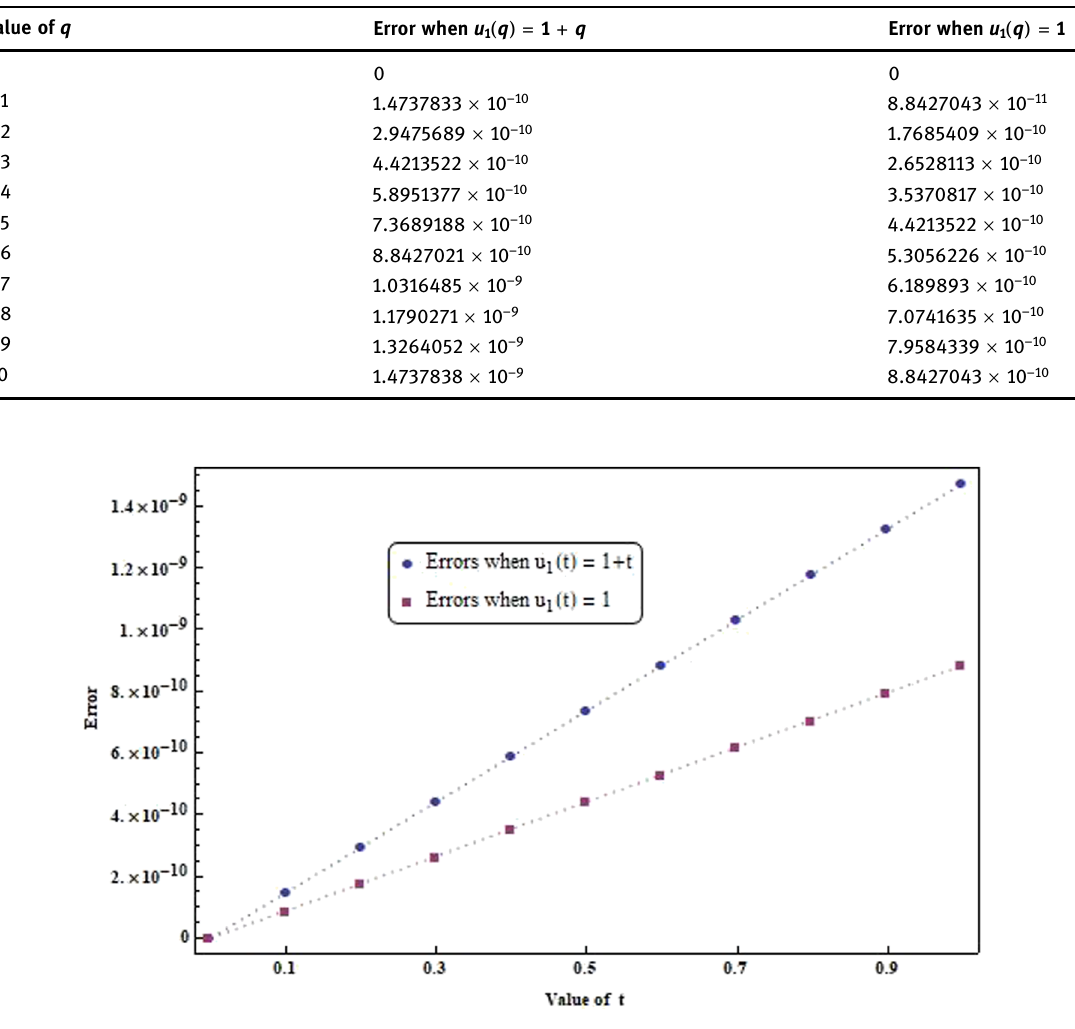
Figure 4: Graph showing errors for di ff erent initial